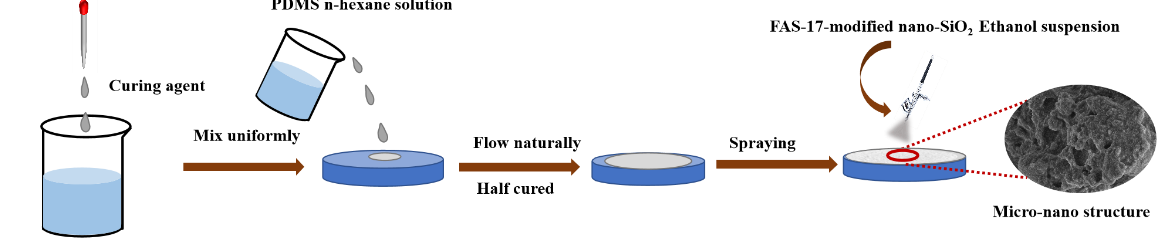
Figure 2. Schematic diagram of the fabrication of FAS-17-modified nano-SiO 2 /PDMS protective coatings on composite insulators.